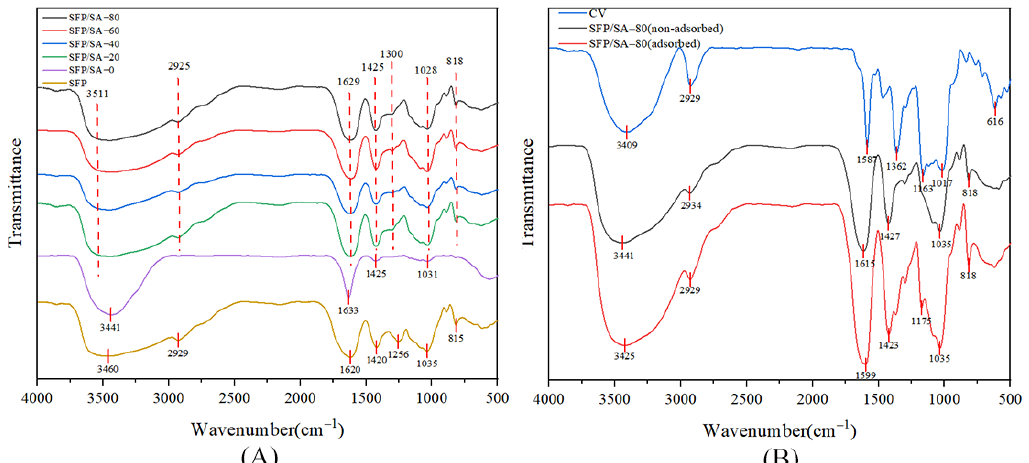
Figure 3. ( A ) The FT-IR spectra of SFP (orange line), SFP/SA-0 (pule line), SFP/SA-20 (green line), SFP/SA-40 (blue line), SFP/SA-60 (red line) and SFP/SA-80 (black line) from 4000 – 500 cm −1 . ( B ) The FT-IR spectra of CV (blue line), SFP/SA-80 non-adsorbed (black line) and SFP/SA-80 adsorbed (red line) from 4000 – 500 cm −1 .